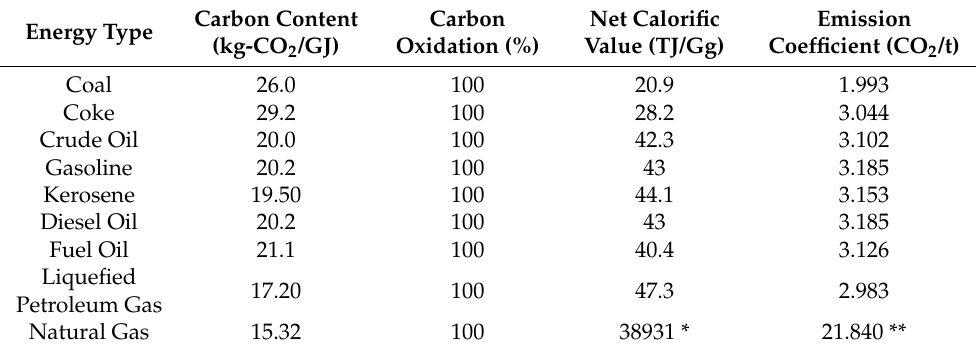
Table 1. CO 2 emissions coefficients of different energy types.